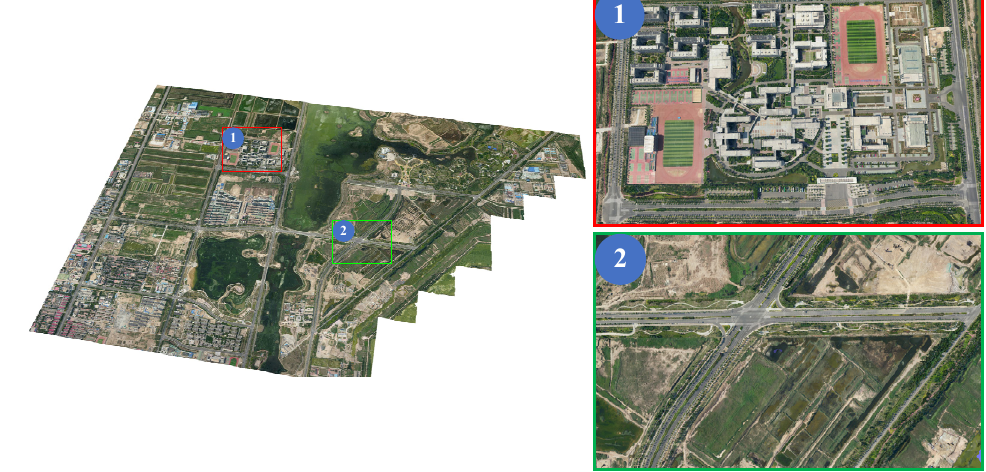
Figure 13. Texture reconstruction results of the experimental area.